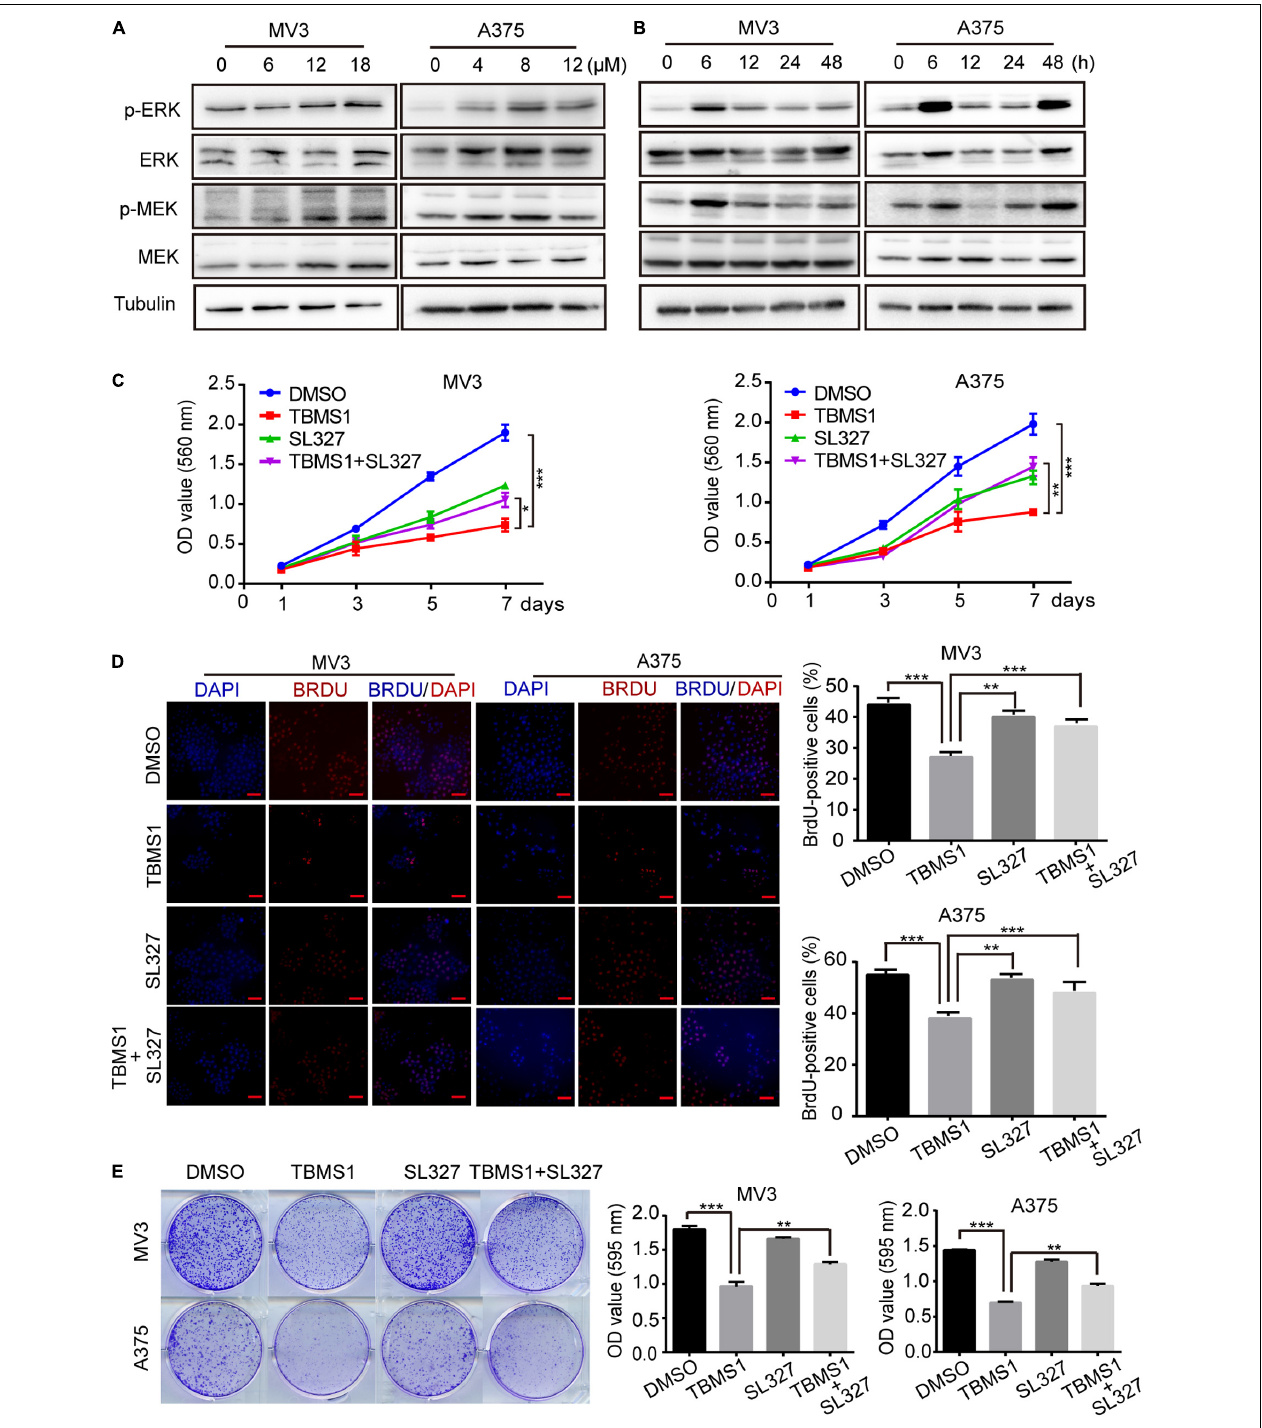
FIGURE 4 | TBMS1 induces hyperactivation of MEK1/2-ERK1/2 cascade in melanoma cells. (A) Western blot was performed to detect the expression levels of p-ERK1/2, ERK1/2, p-MEK1/2, and MEK1/2 in melanoma cells treated with TBMS1 for 48 h. (B) Western blot results showed the expression level of p-ERK1/2, ERK1/2, p-MEK1/2, and MEK1/2 and in melanoma cells treated with TBMS1 in different time for 0, 6, 12, 24, and 48 h. (C) Growth curve of MV3 and A375 cells treated with TBMS1 and 1.25 µ M SL327. DMSO was used as control. (D) BrdU-positive MV3 and A375 cells after treated with TBMS1 and 1.25 µ M SL327 for 48 h. DMSO was used as control. Quantifications of BrdU-positive MV3 and A375 cells were calculated. (E) Clonogenicity of MV3 and A375 cells treated with TBMS1 and 1.25 µ M SL327. The formation of clones after 10 days culture. On the right is the quantitative figure of clonogenic assay results. A two-tailed unpaired Student’s t -test was carried out. * p < 0.05, ** p < 0.01, *** p < 0.001, **** p < 0.0001.